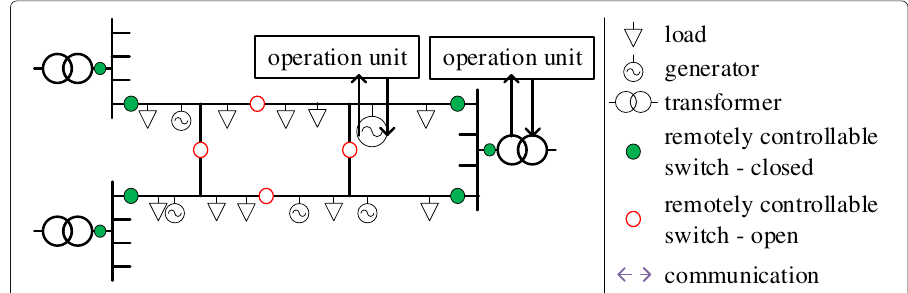
Fig. 1 Local operation architecture for a PV system and transformer. Source: Adapted from Drayer